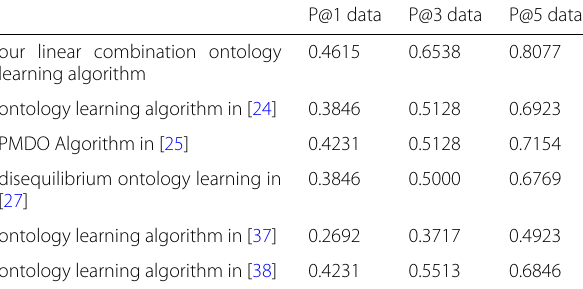
Table 2 Comparing result on mathematical ontology when N = 1, 3, 5